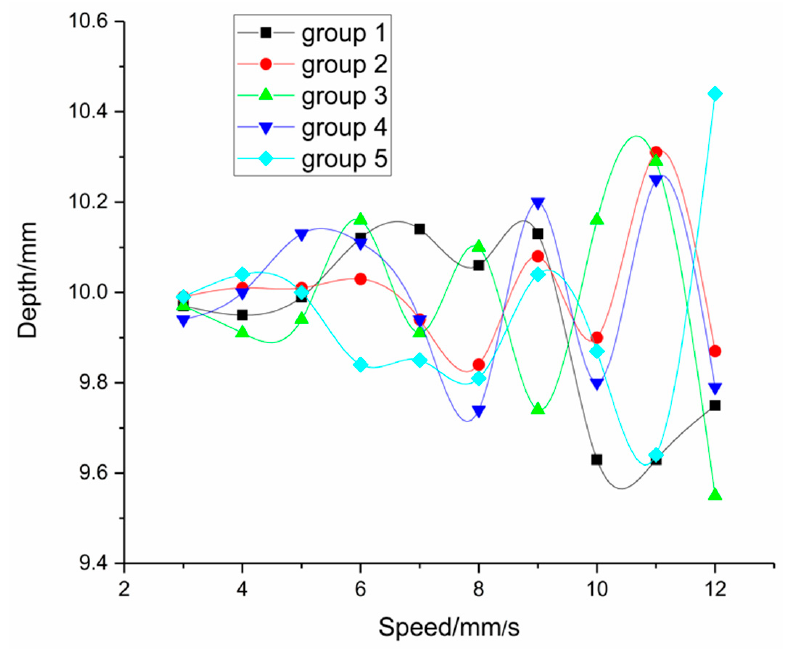
Figure 10. The depth data measured at different feed speeds.